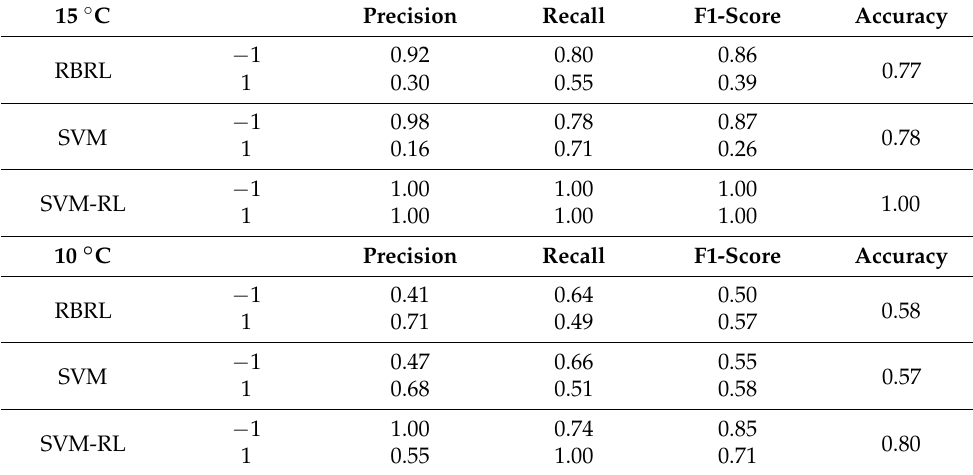
Table 2. The experimental results (mean) of comparison between RBRL, SVM, and SVM-RL on the steelmaking process